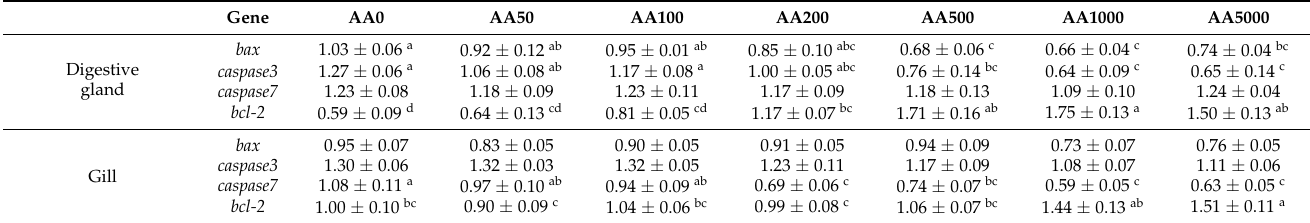
Table 12. Expression levels of apoptosis-related genes in the digestive gland and gill of abalone ( Haliotis discus hannai ) after a 100-day feeding